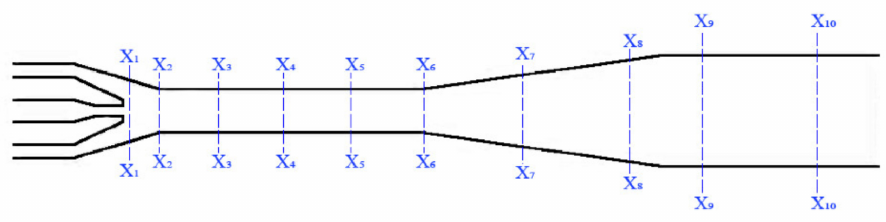
Figure 12. Schematic diagram of ten cross-section positions (X 1 -X 1 to X 10 -X 10